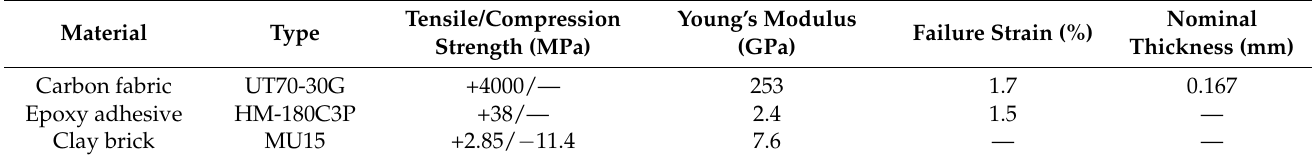
Table 1. Properties of the materials.